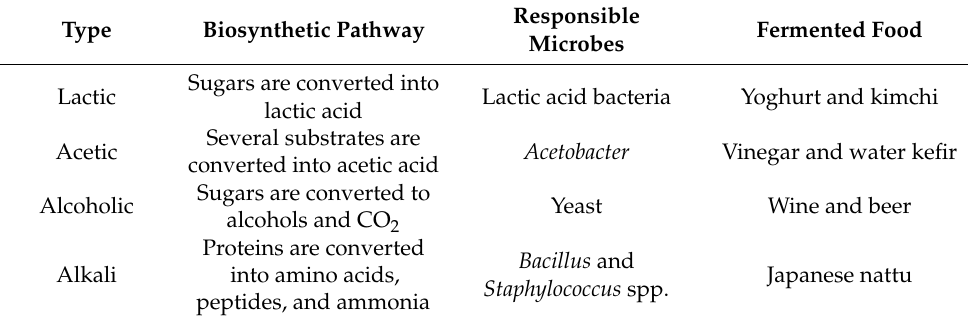
Table 1. Classification of the major types of fermentation related to food